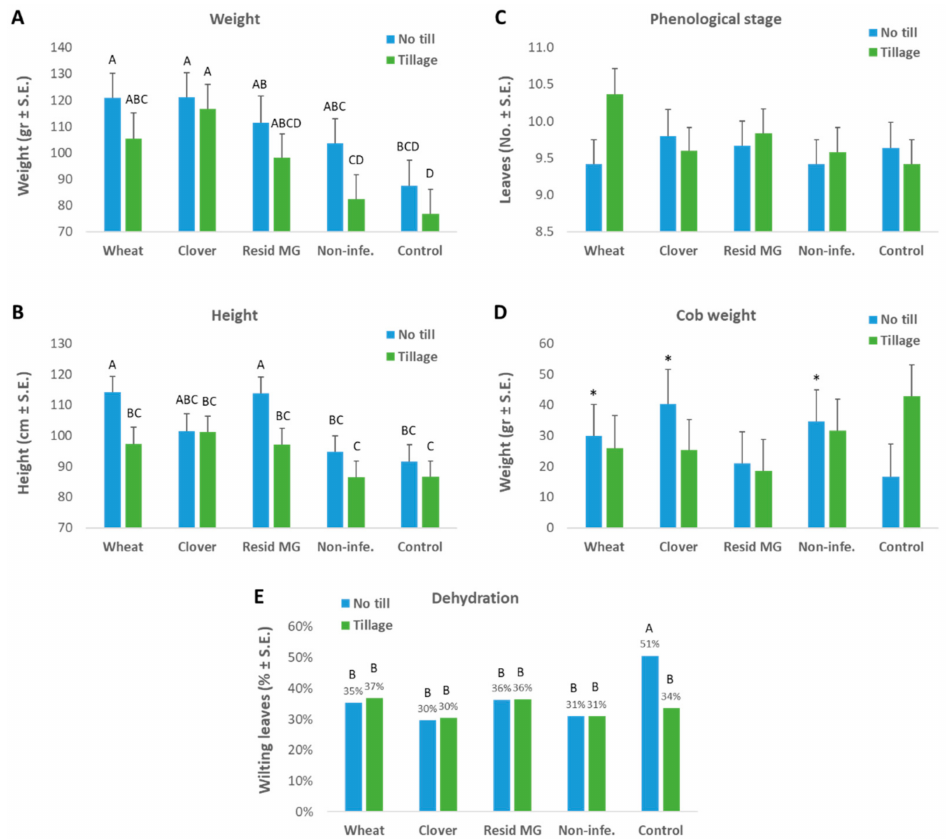
Figure 5. The greenhouse pot experiment—growth parameters at 83 DAS (28 days after fertilization, DAF). The experiment is described in Figure 1. The plants’ growth parameters included fresh weight ( A ), plant height ( B ), phenological stage ( C ), cob yield ( D ) and the plants’ health status ( E ). Non- infe.—reduced-infected soil control. Wilt assessment was based on the percentage of dry leaves in each repeat. Values represent an average of 10 biological replications (pots, each containing one plant) ± standard error. Statistically significant differences (one-way ANOVA, p < 0.05) between treatments at the same measures (if they exist) are indicated by different letters (A–D). Asterisks represent a significant difference ( t -test, p < 0.05) from the tillage soil at the same